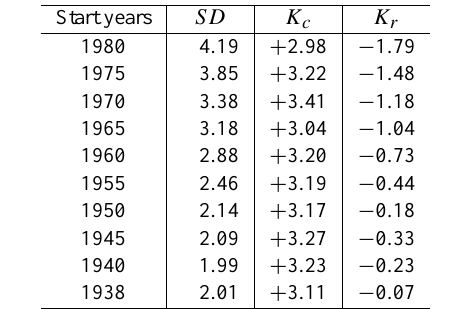
Table 7. The minimal SD (in 10 − 3 ) and corresponding slopes (in 10 − 4 per year) of a complementary K c and residual K r trends for Slough (12:00LT). The start years for the complementary trend to start are shown Start years SD